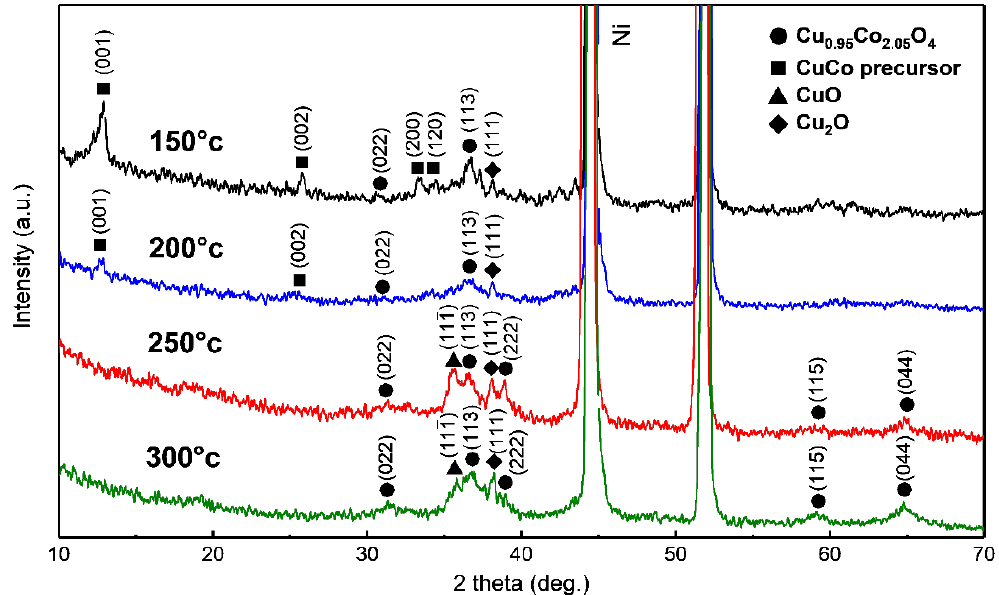
Figure 4. XRD patterns of CCO after treatment at different temperatures: (from top to bottom) 150, 200, 250, and 300 °C.